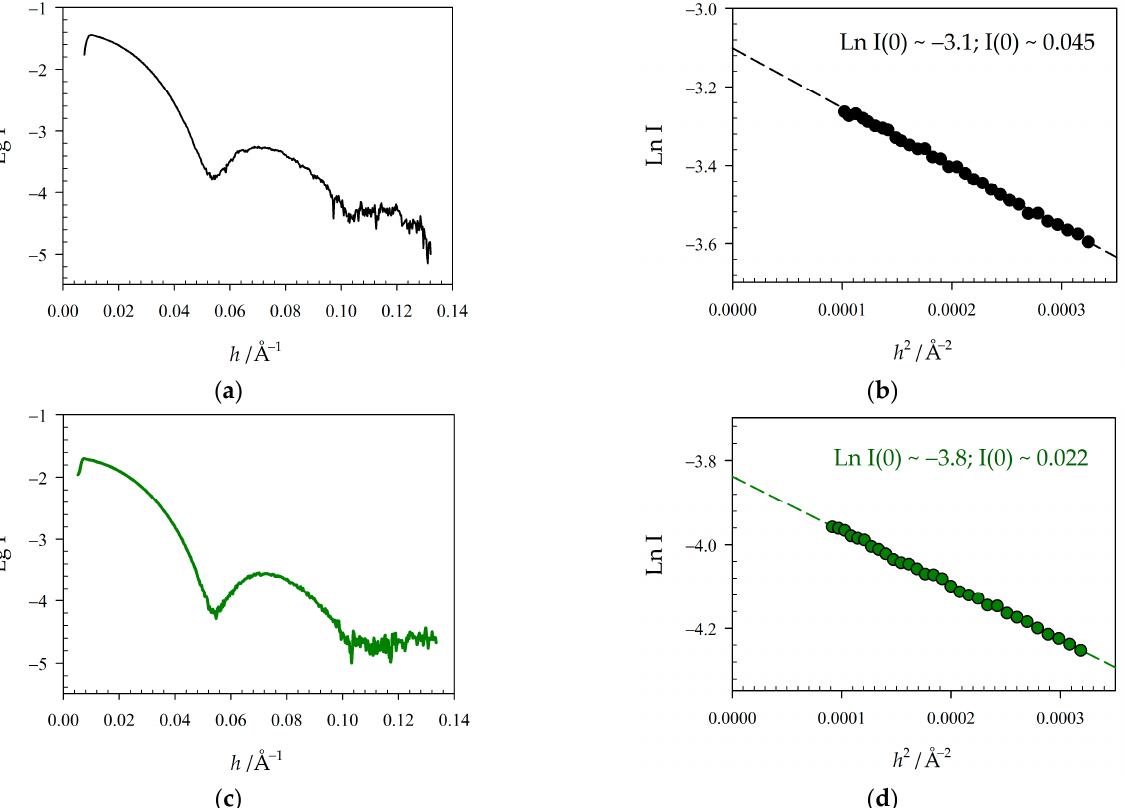
Figure 3. SAXS pattern of WT GroEL 14 population of 5 mg/mL ( a , indicated in black) and GroEL 14 -EGFP population of 2.5 mg/mL ( c , indicated in green); ( b , d ) corresponding Guinier plots; scattering vector h = 4 × ( π / λ ) × sin( θ ), where 2 θ —scattering angle and λ —wavelength; I—X-ray intensity. Radius gyration Rg = 67.7 ± 0.2 (Å) for WT GroEL 14 and 62.5 ± 0.2 (Å) for GroEL 14 -EGFP. Buffer: 20 mM Tris-HCl pH 7.6, 100 mM KCl, 10 mM MgCl 2 .